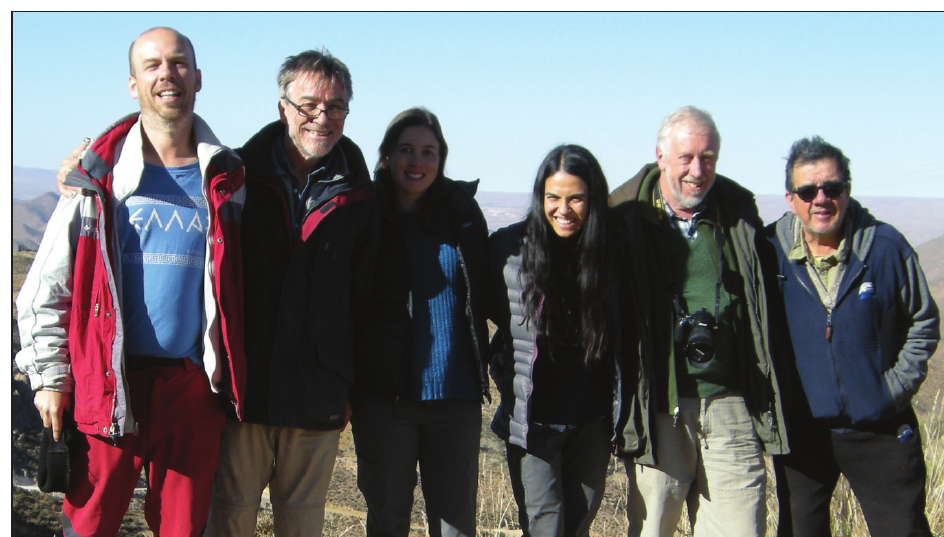
Figure 4: James Steele (second left) with colleagues from IoA and Instituto de Alta Investigación, Universidad de Tarapacá, Chile (Photo James